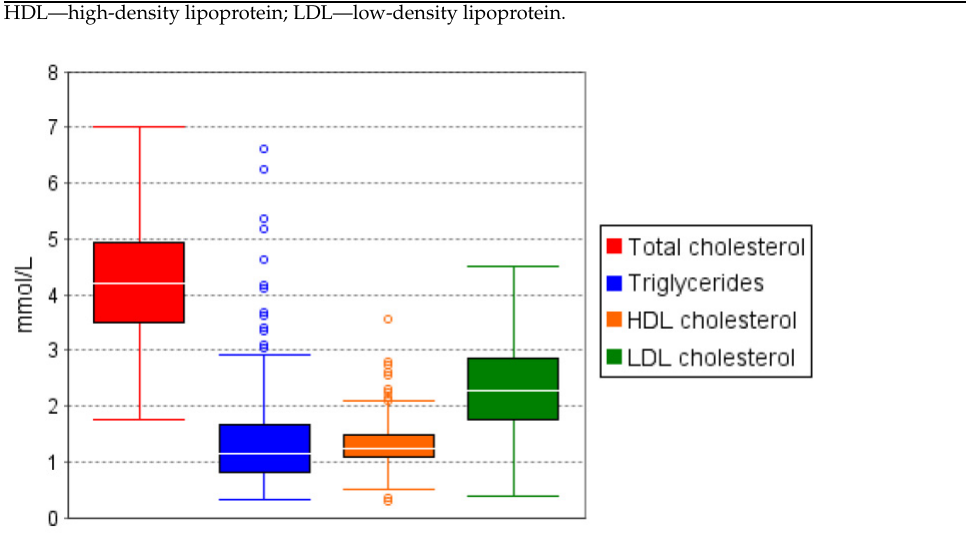
Figure 6. Boxplot for the lipids. Table 4. Prevalence of